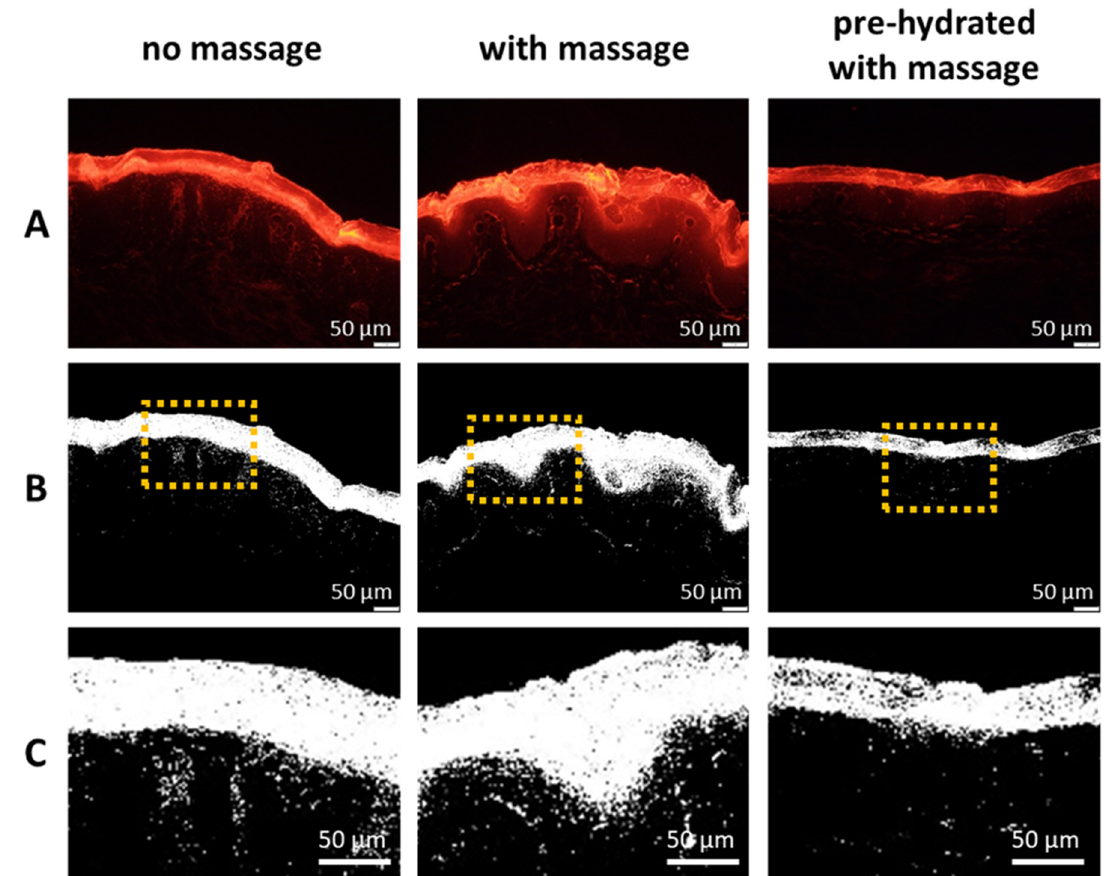
Figure 10. Influence of application, formulations, and skin condition on skin hydration and penetration efficacy of Nile red. ( A ): original images of skin sections obtained from epifluorescence microscopy, ( B ): images from ( A ) after digital RGB-threshold, ( C ): digital zooms of the dashed image sections from ( B ).